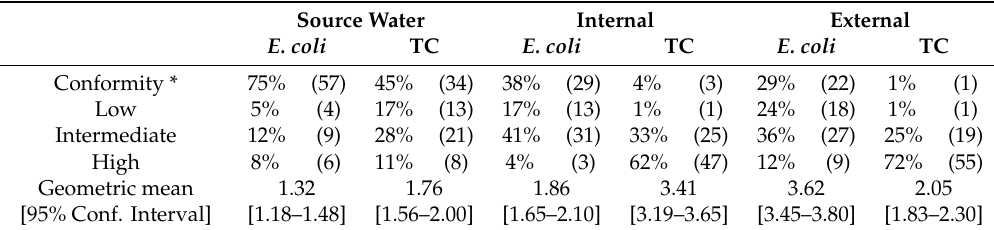
Figure 1. Contamination levels for Escherichia coli ( left ) and total coliforms ( right ). Table 3. Summary of the microbiological results (% samples in each category and ( N )). Geometric mean concentrations are in units of CFU / 100 mL.